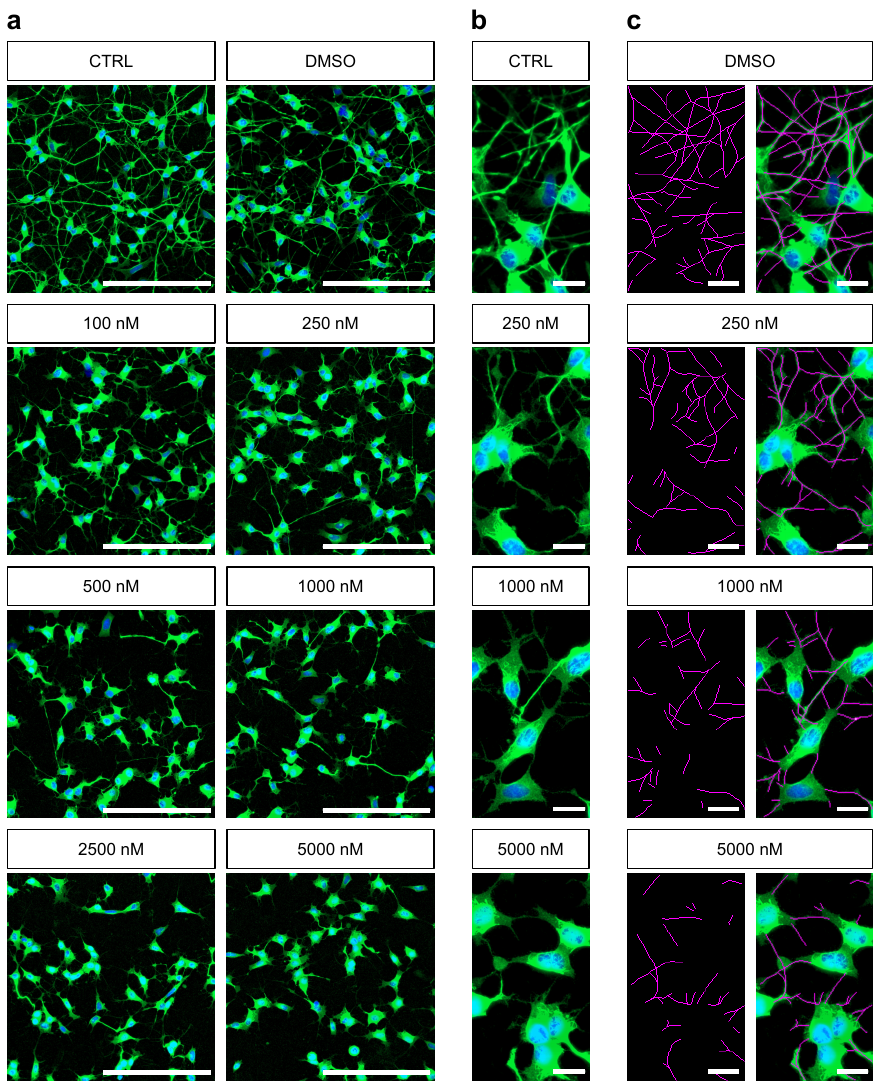
Figure 2. Dose-dependet effect of different Rotenone concentrations (100 nM, 250 nM, 500 nM, 1000 nM, 2500 nM and 5000 nM) on differentiated SH-SY5Y cells: ( a ) Representative micrographs of differentiated SH-SY5Y cells 24 h after treatment with Rotenone and control conditions. Stained against Neurofilament (green). Cell nuclei were stained with DAPI (blue). Scale bar = 200 µm. ( b ) Cell morphology of differentiated SH-SY5Y cells in higher magnification. Stained against Neuro- filament (green). Cell nuclei were stained with DAPI (blue). Scale bar = 20 µm. ( c ) Exemplary annota- tion of neurite outgrowth performed manually with the ImageJ-Plug-In NeuronJ. Scale bar = 20